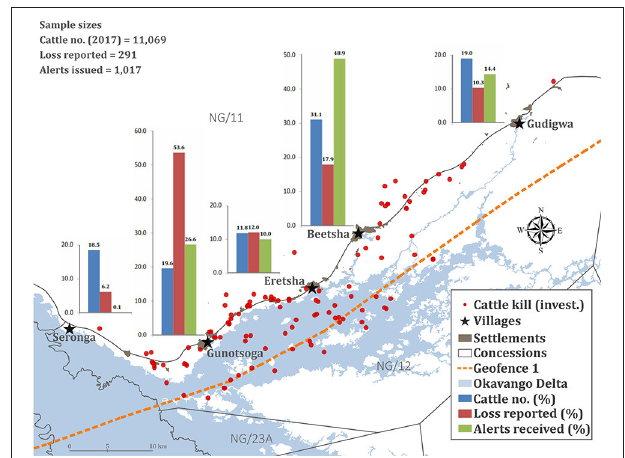
FIGURE 3 | Proportional distribution of cattle, livestock losses to lions, lion alert messages received and investigated (invest.) conflict locations across the study area in northern Botswana. Except for cattle holdings that were determined in 2017, data represent the lion alert pilot study from 13 May 2016 until 12 May